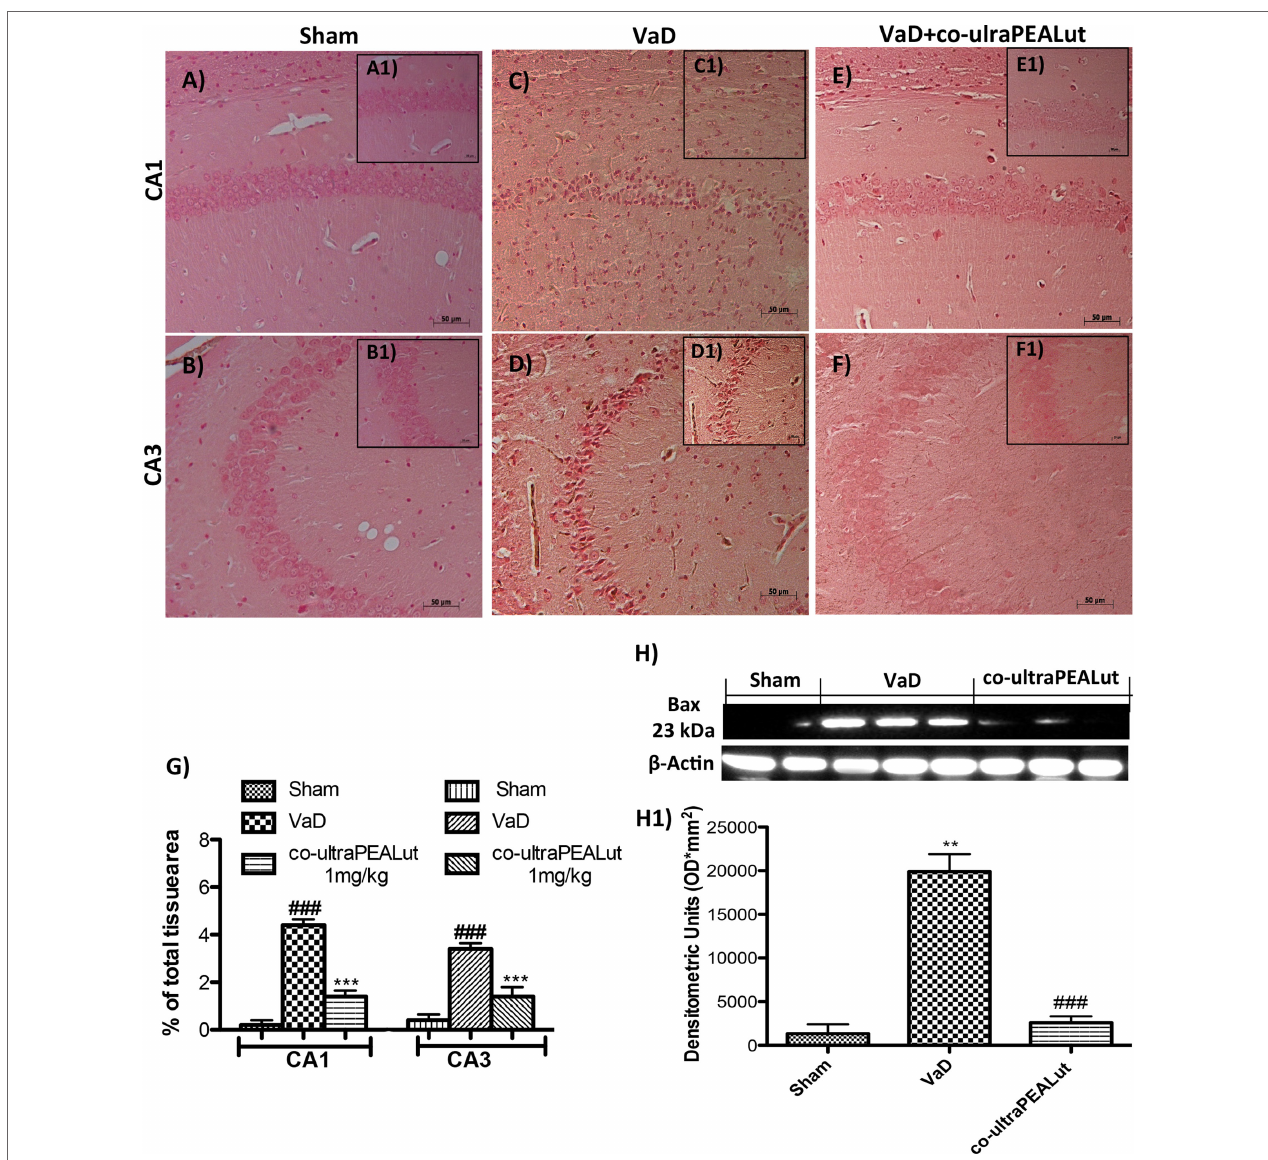
FigUre 5 | effects of co-ultraPealut on proapoptotic protein in VaD mice . Immunohistochemical analysis showed that Bax was significantly increased after carotid arteries ligation in hippocampal CA1 and CA3 regions [ (a,a1,B,B1) vs. (c,c1,D,D1,g) ]; instead, treatment with co-ultraPEALut restored Bax